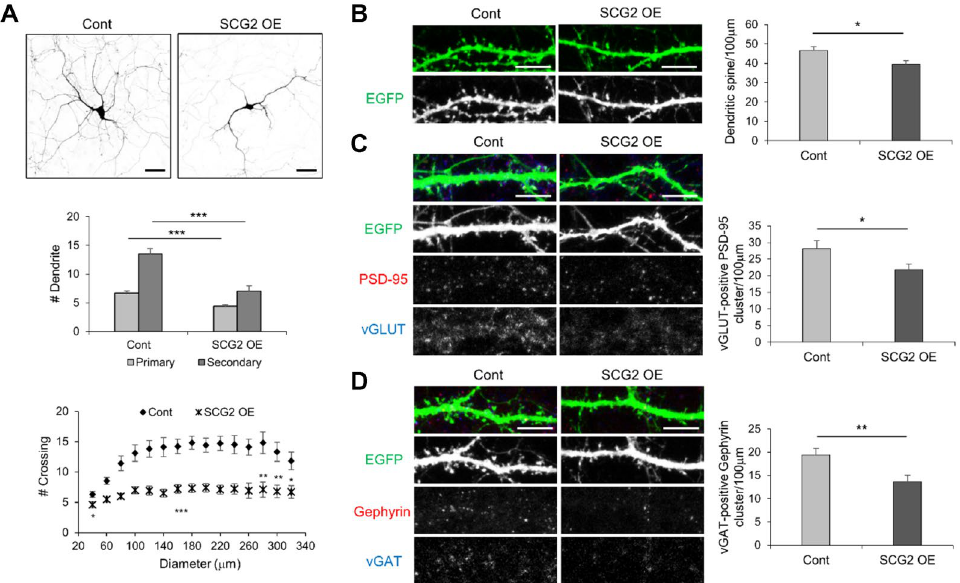
Figure 4. Dendritic arborization and synaptic formation attenuated by SCG2 overexpression. ( A ) Attenuated dendritic arborization by SCG2 overexpression. Rat hippocampal neurons were transfected with human SCG2 clone (hSCG2) (Fig. S1B). The numbers of dendrites and arborization significantly decreased after SCG2 overexpression (SCG2 OE) as compared with that in the control group that expressed EGFP only (Cont). Means ± s.e.m. of data from 10 control neurons (Cont) and 10 hSCG2 neurons (SCG2 OE) are shown. For primary dendrites: *** p < 0.001; for secondary dendrites: *** p < 0.001; for Sholl analysis of arborization: * p < 0.05, ** p < 0.01, and *** p < 0.001 (Student’s t-test). Scale bar: 50 μm. ( B–D ) Decreased synaptic formation by overexpression of SCG2. The density of dendritic spines and the numbers of excitatory and inhibitory synapses significantly decreased after SCG2 overexpression (SCG2 OE) as compared with that in the control group (Cont). Means ± s.e.m. of data from 28 dendrites of 7 control neurons (Cont) and 28 dendrites of 7 hSCG2 neurons (SCG2 OE). ( B ) The density of dendritic spines: * p < 0.05. ( C ) The numbers of excitatory synapses: * p < 0.05. ( D ) The numbers of inhibitory synapses: ** p < 0.01 (Student’s t-test). Scale bar: 10